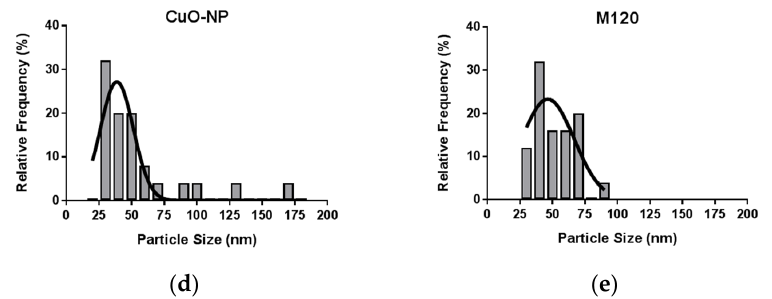
Figure 1. Characterization of CuO-NP and M120 nanoparticles. ( a , b ) show the effective diameter of nanomaterial/particles as measured by nanoparticle tracking analysis (NTA); ( c ) shows the trans- mission electron microscopy (TEM) characterization of size/shape of the nanoparticles; ( d , e ) show the plotted histograms displaying the variability in particle size for CuO-NP and M120.